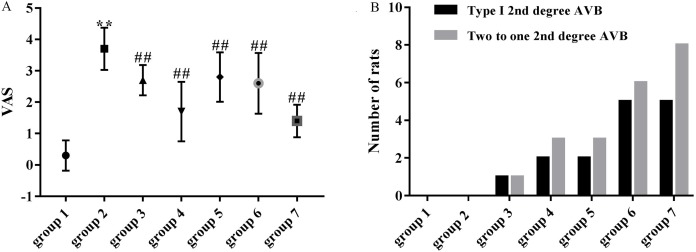
Effects of ART and VER on VAS and number of rats that presented with type I second degree AVB and two to one second degree AVB in all groups.(A) Obvious effects of ART (75, 150, 300 and 600 mg/kg) and VER (1 mg/kg) on VAS in response to LV afterload increases. (B) Number of rats that presented with type I second degree AVB and two to one second degree AVB in each group. **p < 0.01 vs group 1, ##p < 0.01 vs group 2. VAS, ventricular arrhythmia score; AVB, atrioventricular block.